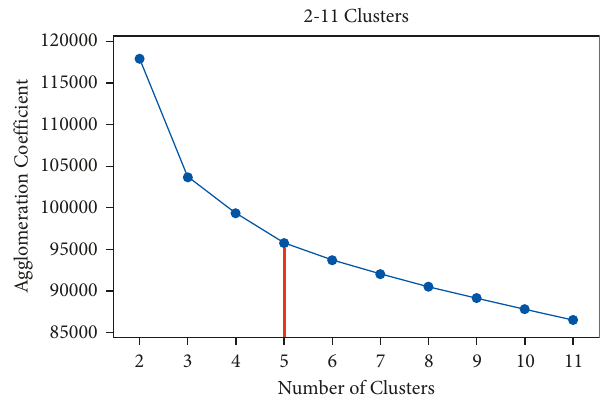
Figure 4: Plot of agglomeration coefficient against a number of clusters.